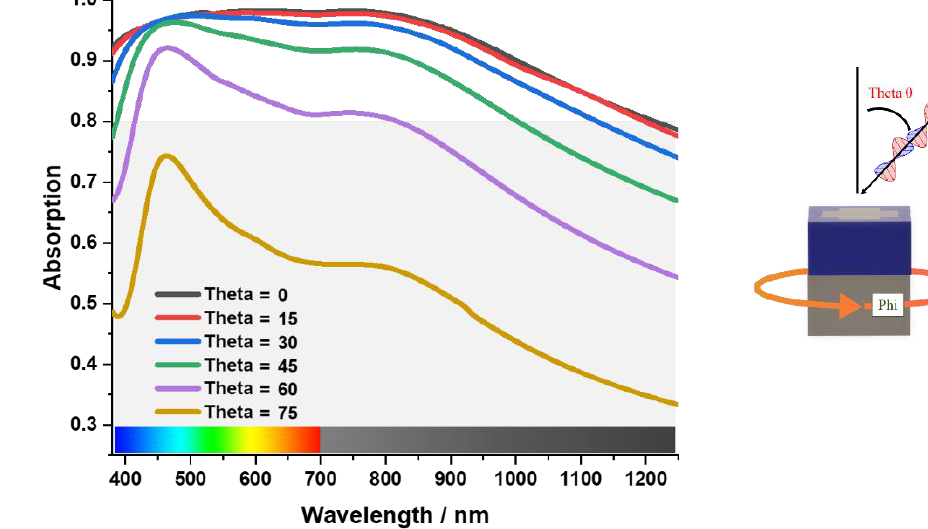
Figure 9. Angular-stability characteristics of the absorber.